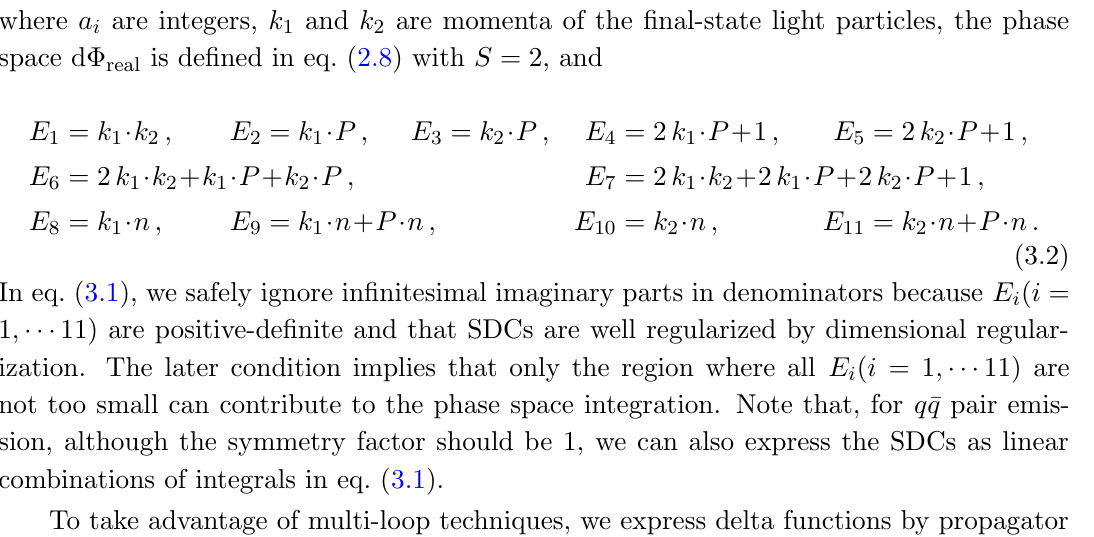
Figure 4 . One of the two Feynman diagrams for g ! Q (cid:22) Q ( 1 S [1 ; 8] obtained by permuting the heavy quark and